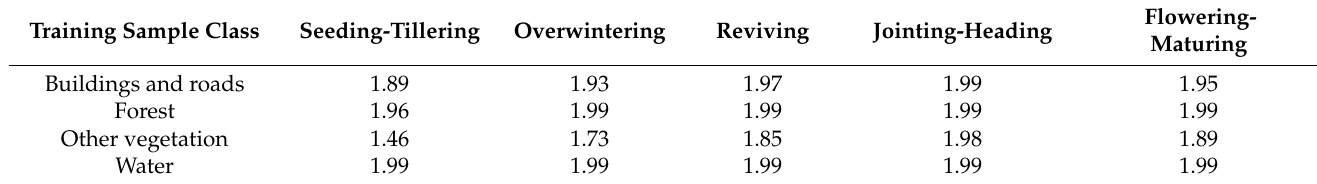
Table 4. Jeffries-Matusita distance between winter wheat and other land-cover